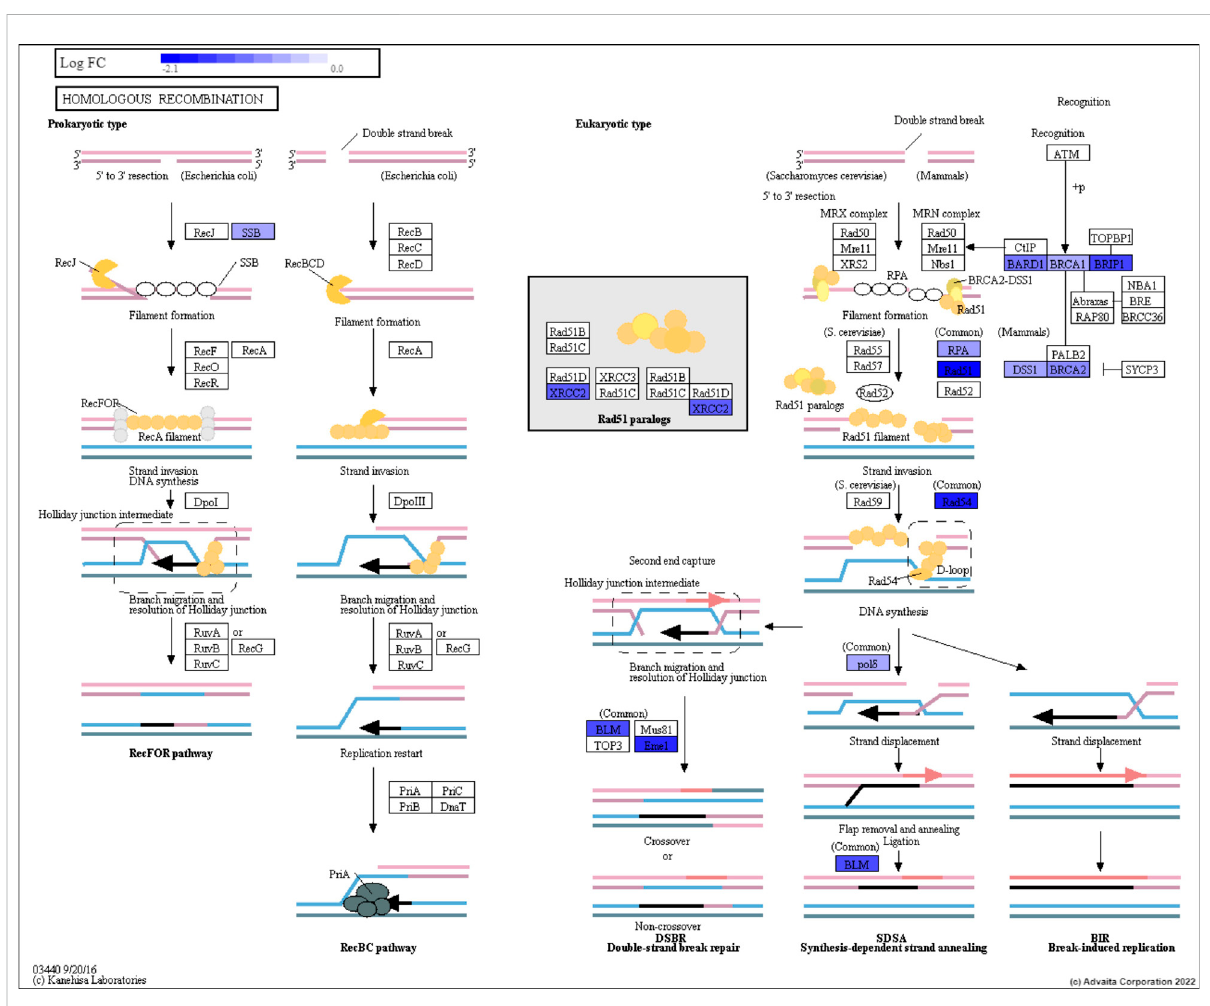
FIGURE 1 The Homologous Recombination pathway. The genes are represented in the rectangular boxes, with the shades of blue representing down- regulated genes for prostate cancer